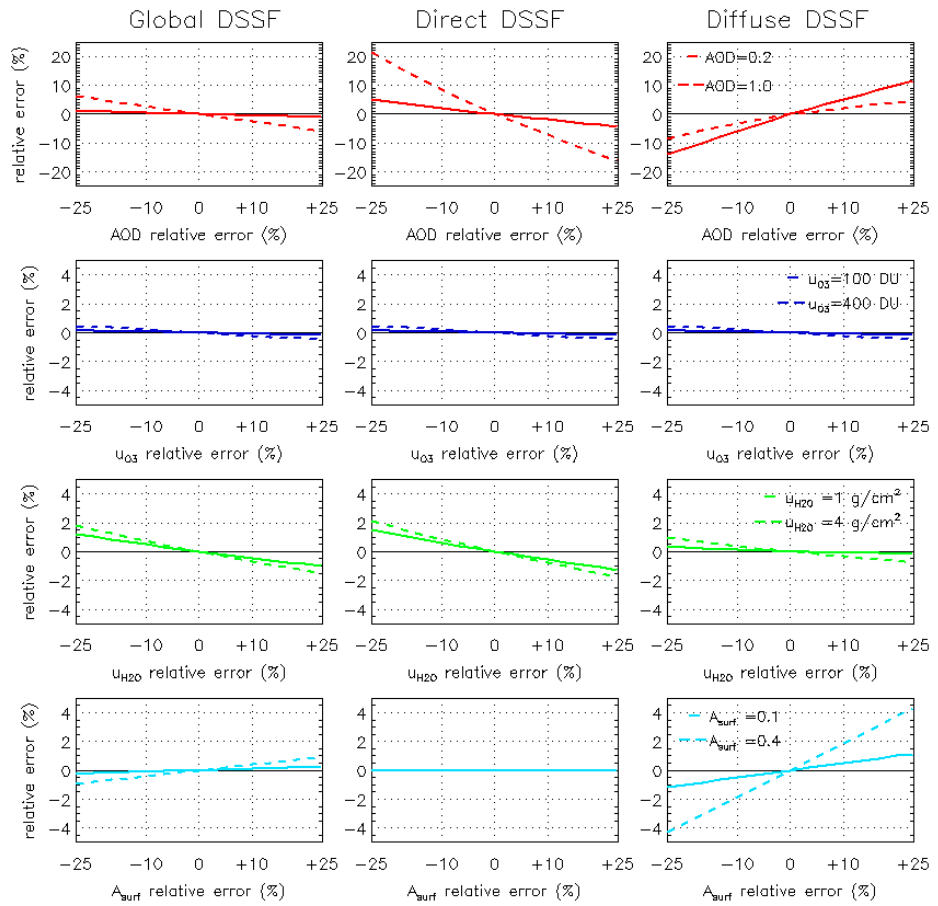
Figure 5. Relative error on global, direct, and diffuse DSSF computed with SIRAMix caused by uncertainties in terms of relative error affecting AOD (first-line figures), ozone content (second-line figures), water vapor concentration (third-line figures), and surface albedo (fourth-line figures). Two cases corresponding to different contents of the atmospheric component under study are studied (see plain and dashed lines). Note the different vertical scale for the study on the